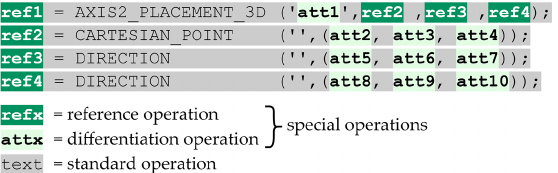
Figure 5. General structure of the item coordinate system for the CAD system Creo Parametric 6.0.5.0.